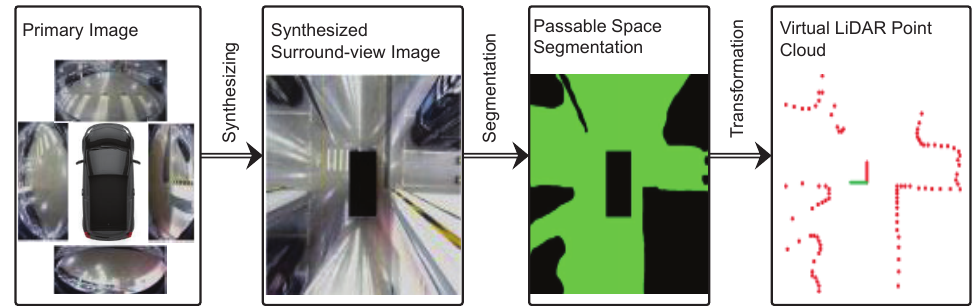
Figure 2. The process of virtual LiDAR data